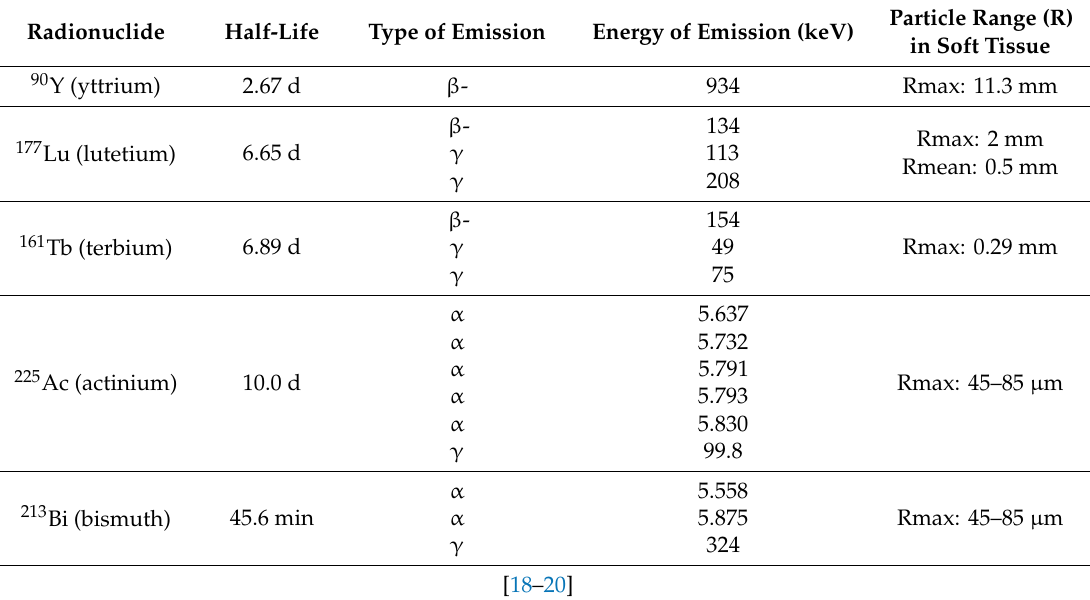
Table 2. Characteristics of theragnostic radionuclides used in patients with